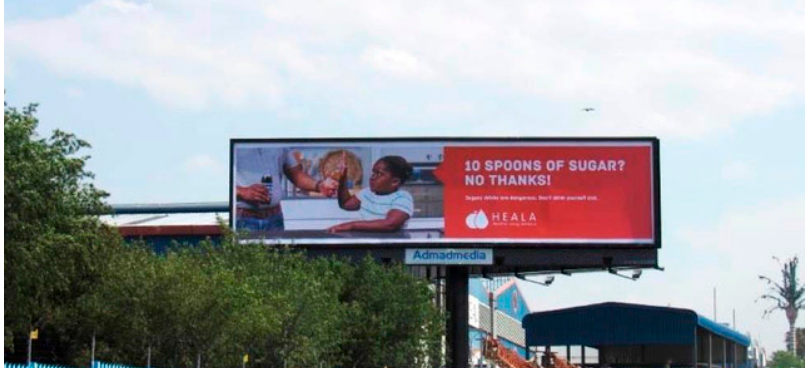
Figure 1. Photograph of outdoor media (billboard) from the campaign, “10 spoons of sugar? No thanks!”